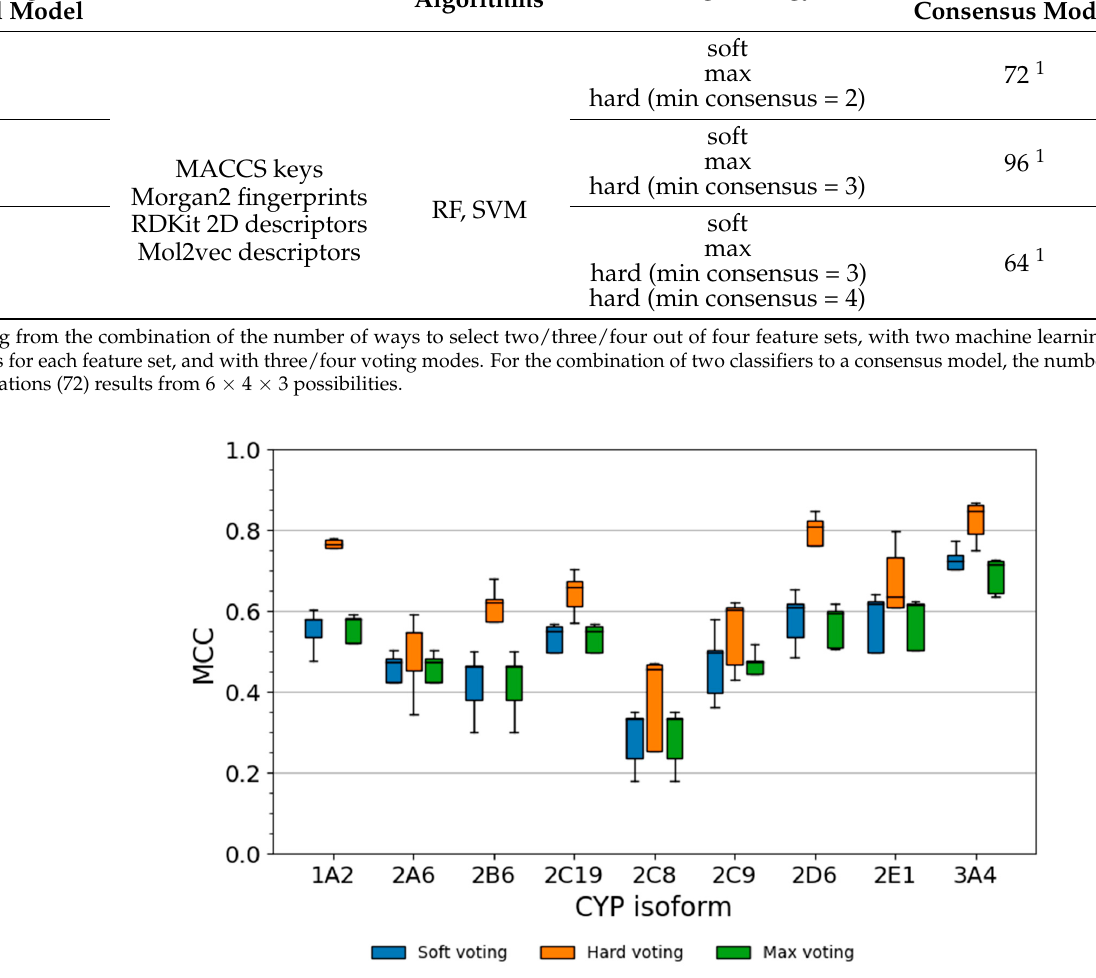
Figure 8. Five ‐ fold CV performance (quantified as MCC) for the best combined models for each voting strategy. Whiskers mark the range of the non ‐ outlier data which is defined as lower quartile − 1.5 interquartile range up to upper quartile +1.5 interquartile